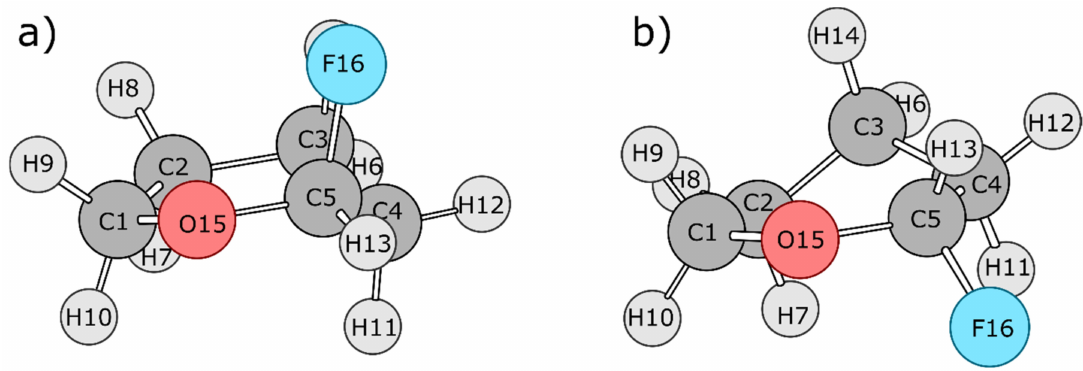
Figure 4. QST-2 optimized transition state geometry for the ( a ) R isomer and ( b ) S isomer of